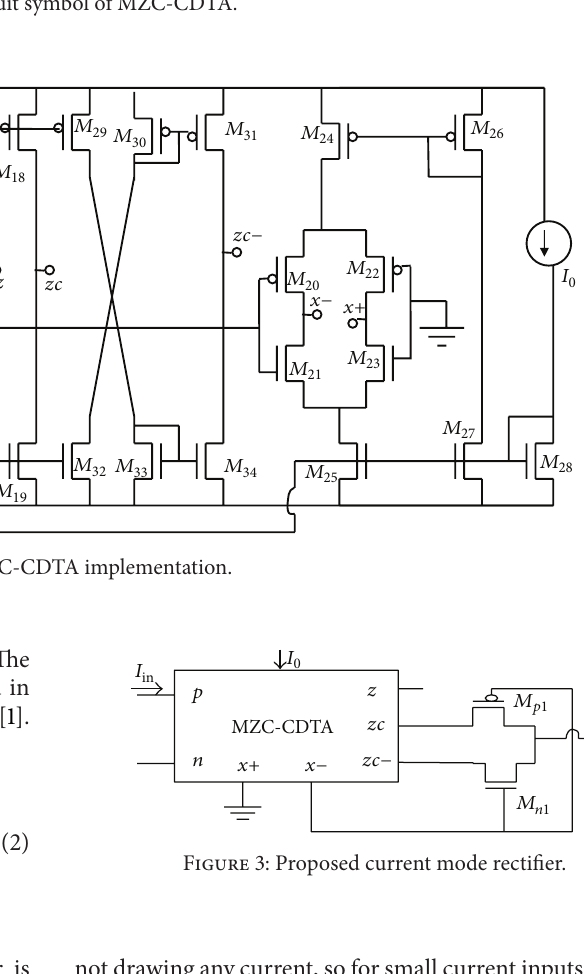
Figure 1: Circuit symbol of MZC-CDTA.